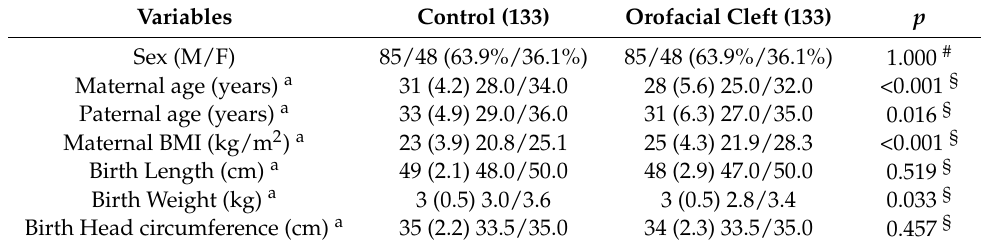
Table 1. Descriptive analysis by each group.